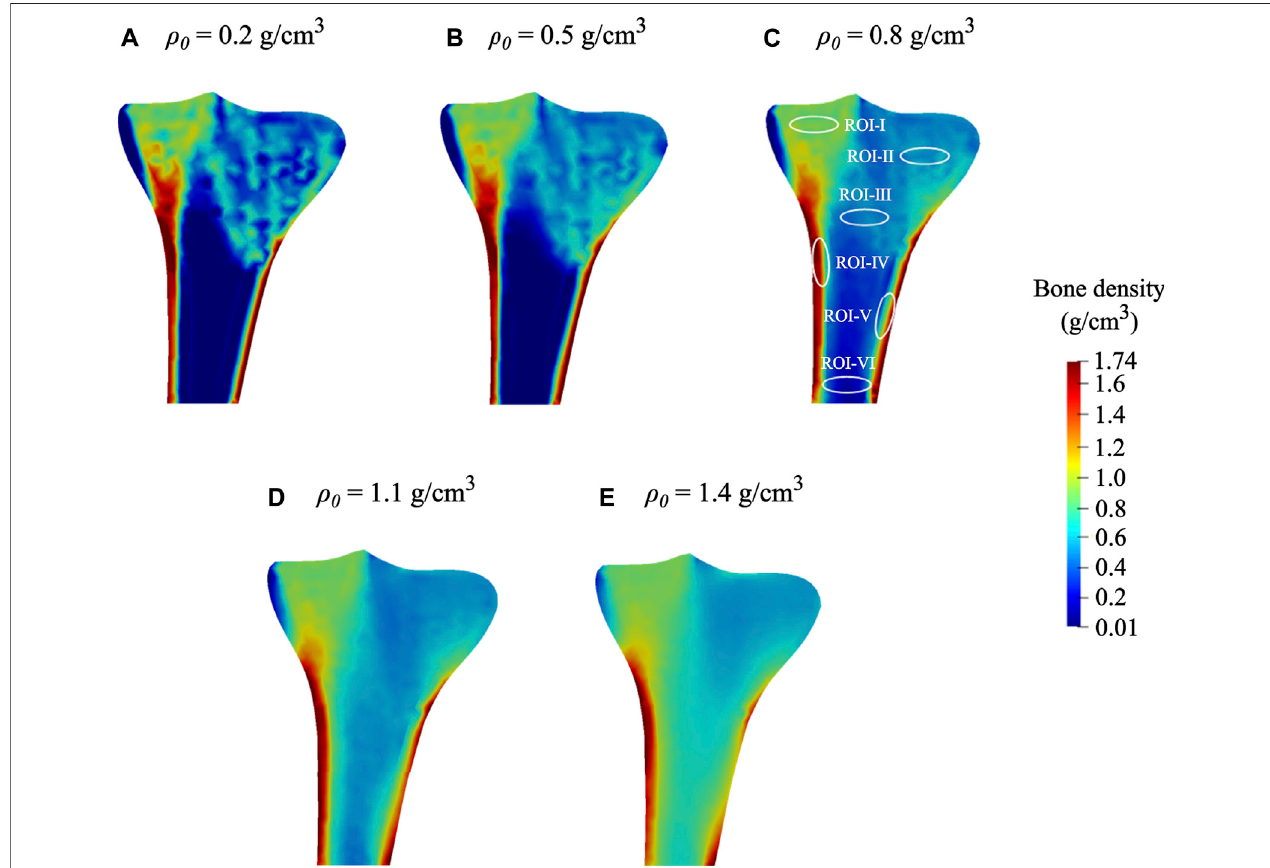
FIGURE6 | Final bone density distributions ( t (cid:1) 300 days) obtained for distinct valuesof uniforminitial density: (A) ρ 0 (cid:1) 0.2 g/cm 3 . (B) ρ 0 (cid:1) 0.5 g/cm 3 , (C) ρ 0 (cid:1) 0.8 g/ cm 3 (local regions of interests (ROIs) highlighted with white ellipses), (D) ρ 0 (cid:1) 1.1 g/cm 3 , and (E) ρ 0 (cid:1) 1.4 g/cm 3 .